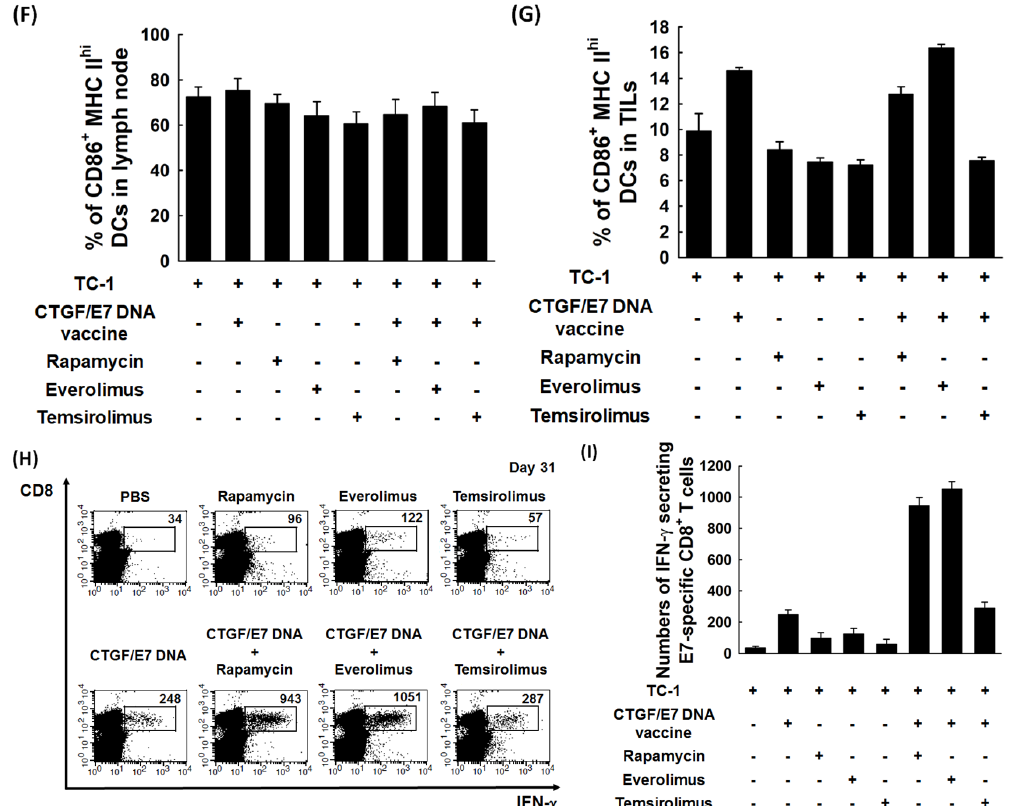
Figure 7. Anti-tumor e ff ects and immune alteration of mice treated with CTGF / E7 DNA vaccine and / or mTORi. ( A ) Diagrammatic representation of di ff erent treatment protocols using CTGF / E7 DNA vaccine and / or mTORi. Note: G1: PBS only; G2: CTGF / E7 DNA vaccine; G3: Rapamycin; G4: Everolimus; G5: Temsirolimus; G6: CTGF / E7 DNA vaccine and rapamycin; G7: CTGF / E7 DNA vaccine and everolimus; G8: CTGF / E7 DNA vaccine and temsirolimus. ( B ) E ff ects of mTORi on TC-1 tumor cells. The